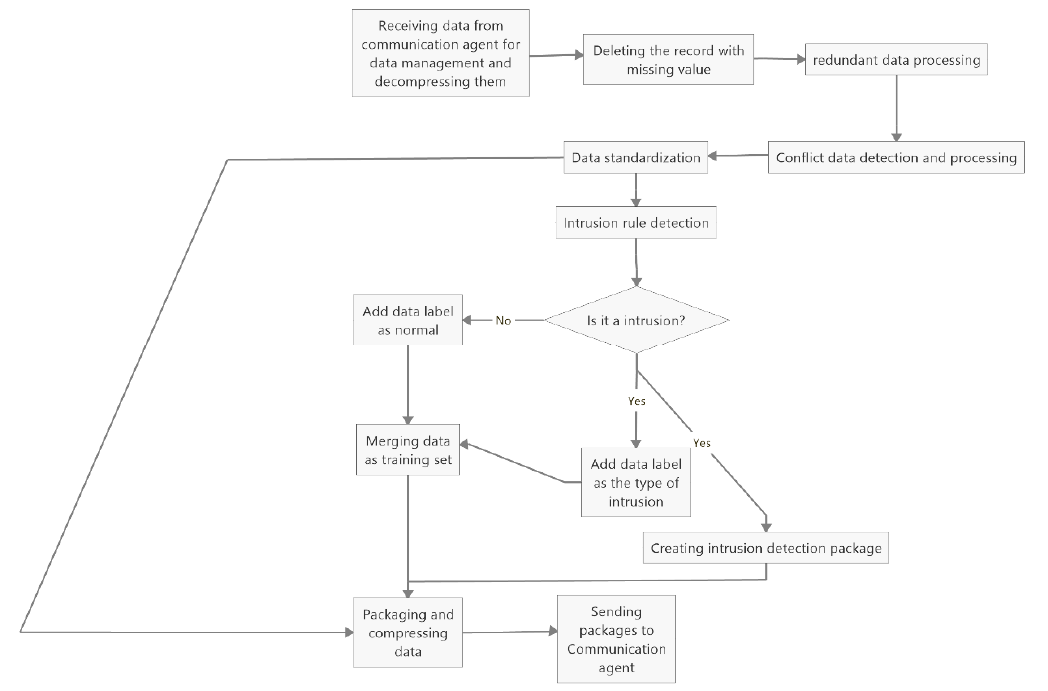
Figure 5. Process of data management agents.